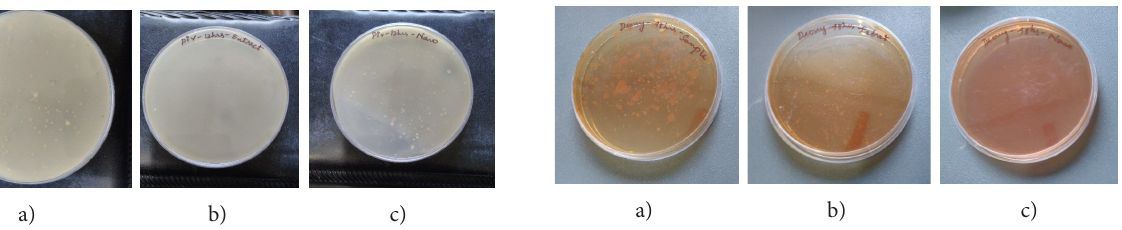
Figure 9. Total bacterial count ( Salmonella colonies) in Deoxycholate citrate agar – values are expressed as Mean ( n = 3)